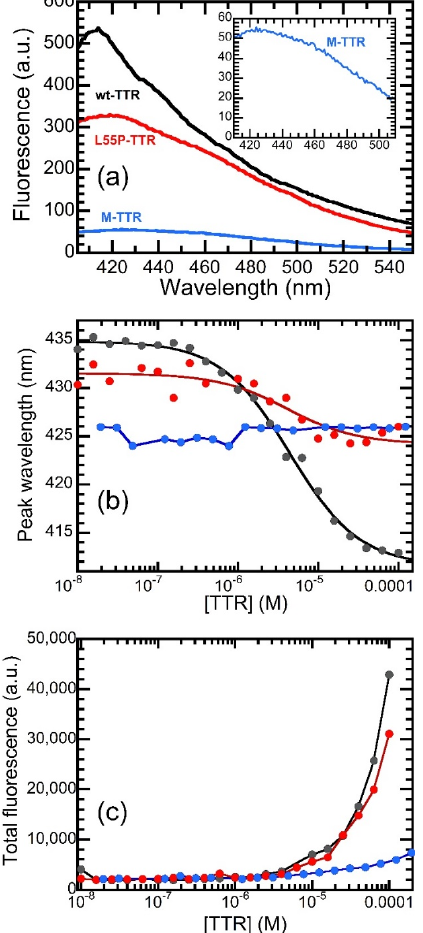
Figure 4. Interaction between OleA and TTR mutants. ( a ) Comparison between the emission of OleA at a concentration of 0.5 µM in the presence of 100 µM wt-TTR (black), L55P-TTR (red), and M-TTR (blue). The inset shows a magnification of the spectrum recorded in the presence of M-TTR. ( b ) Peak wavelength of the OleA spectra as a function of the concentration of wt-TTR (black), L55P-TTR (red), and M-TTR (blue). ( c ) Total fluorescence emitted by OleA as a function of the concentration of wt-TTR (black), L55P-TTR (red), and M-TTR (blue).